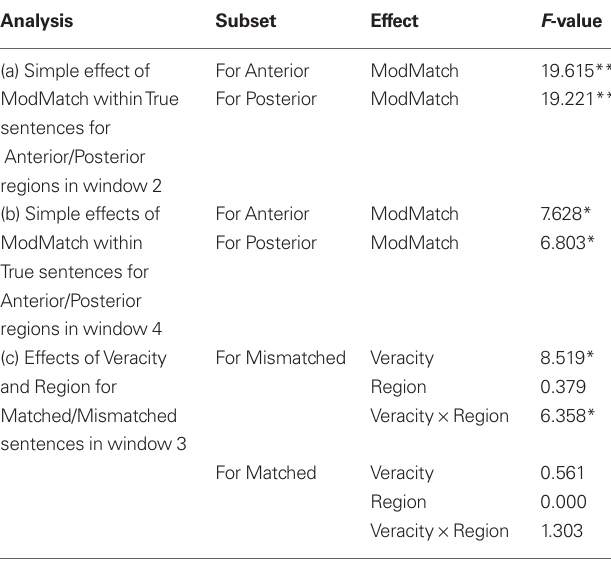
Table 3 | Results of the simple effects follow-up